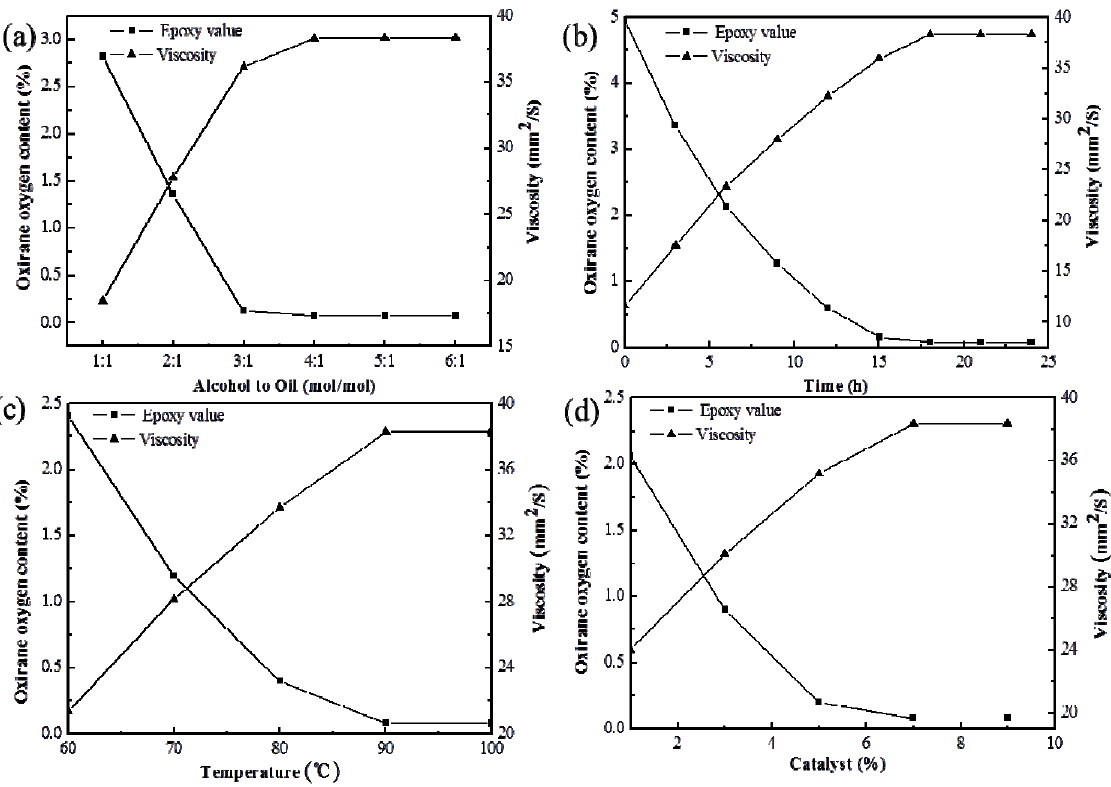
(dry) (Figure 1c). The oxirane oxygen content decreases and the viscosity increases with increasing reaction temperature. Above 90 ˝ C, however, the changes in the oxirane oxygen content and the 40 ˝ C viscosity become negligible, indicating the completion of the reaction. Therefore, 90 ˝ C was selected as the optimal reaction temperature, with a 0.081% oxirane oxygen content and a 38.32 mm 2 /s viscosity at 40 ˝ C.